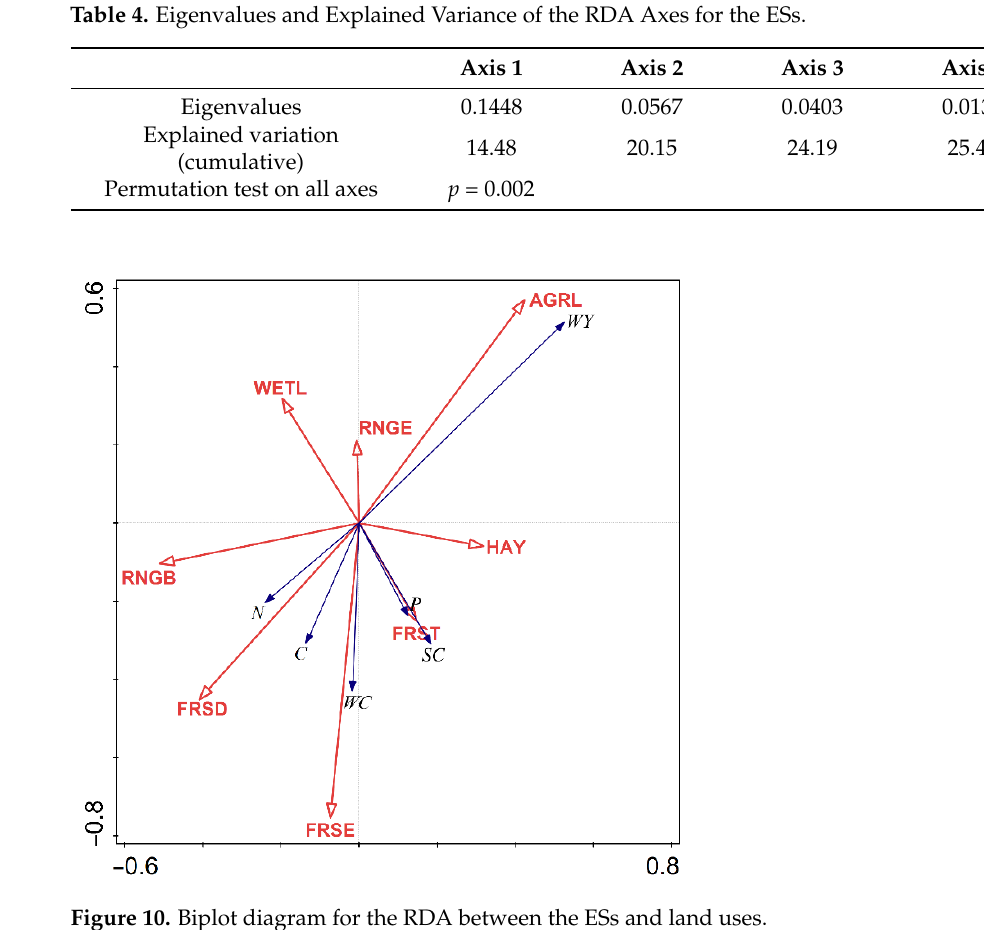
Figure 10. Biplot diagram for the RDA between the ESs and land uses.